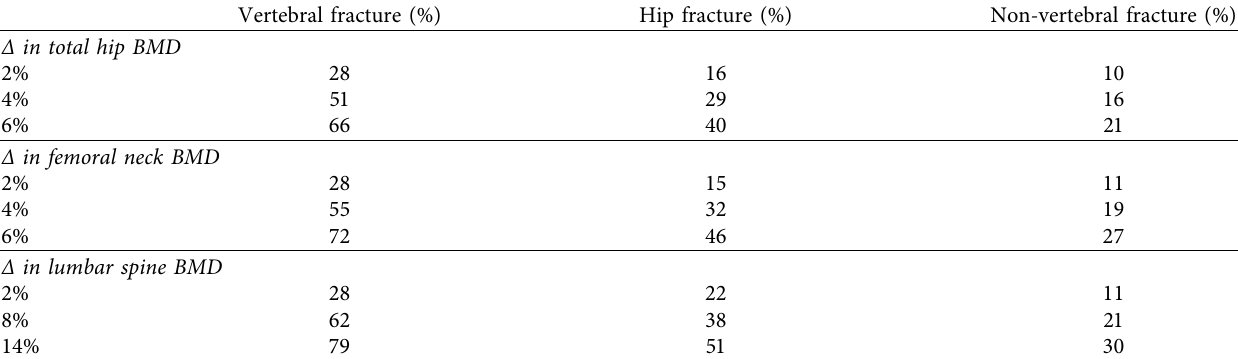
Table 2: Estimated fracture risk reduction associated with BMD improvement [83].